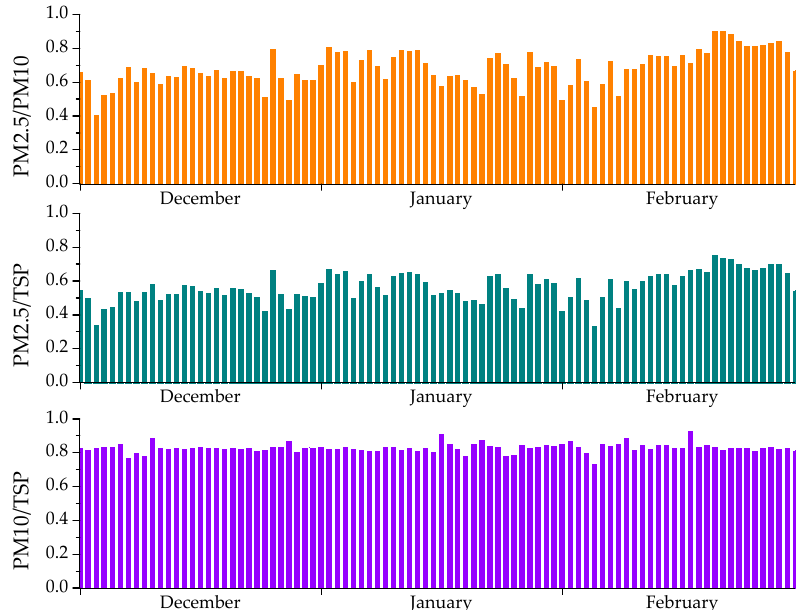
Figure 3. Variation of PM.